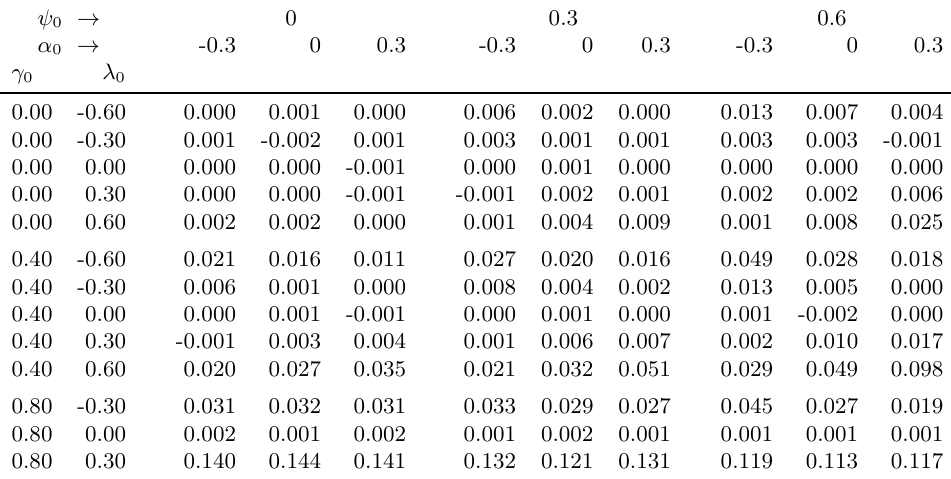
Table D.2: Bias of Team Dynamic – autoregressive parameter.